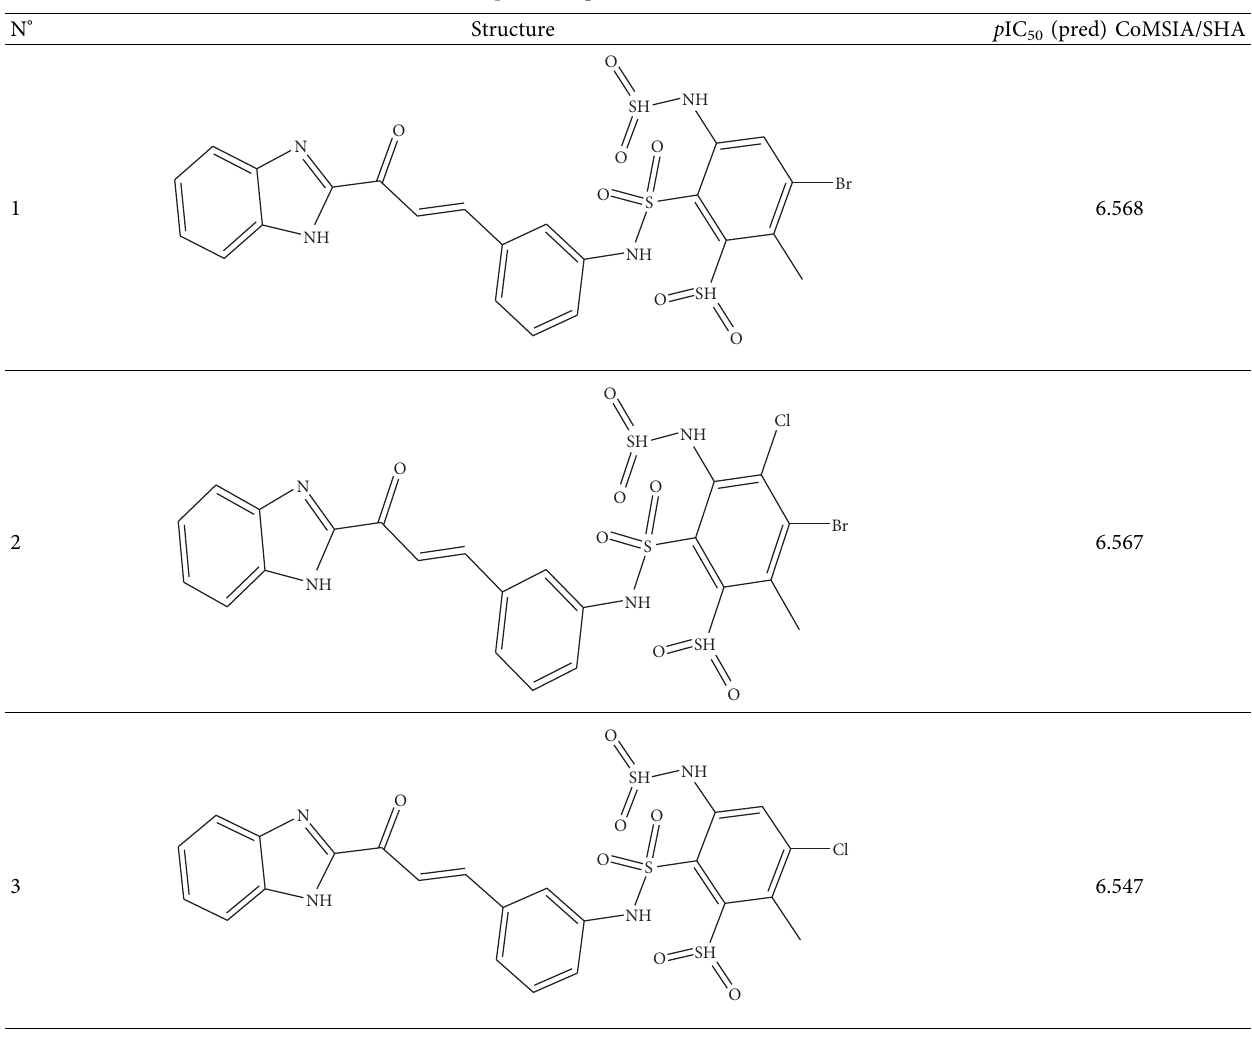
Table 7: Structures and their predicted p IC 50 based on the 3D-QSAR (COMSIA)